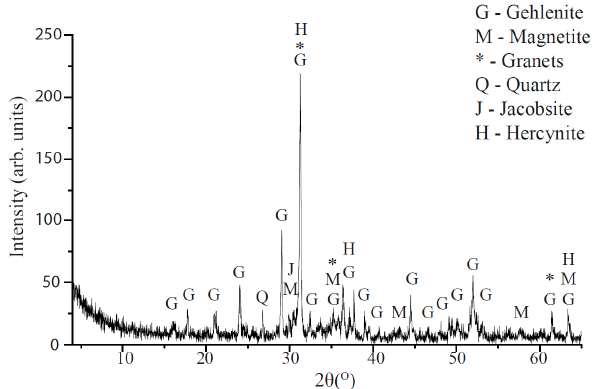
Figure 9. XRD analysis of slag.